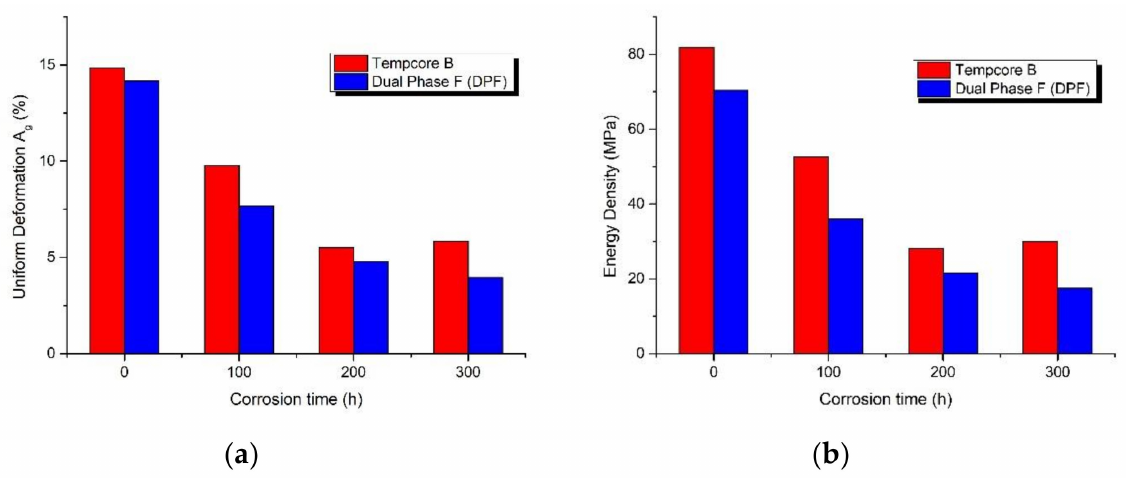
Figure 13. ( a ) Uniform deformation and ( b ) energy